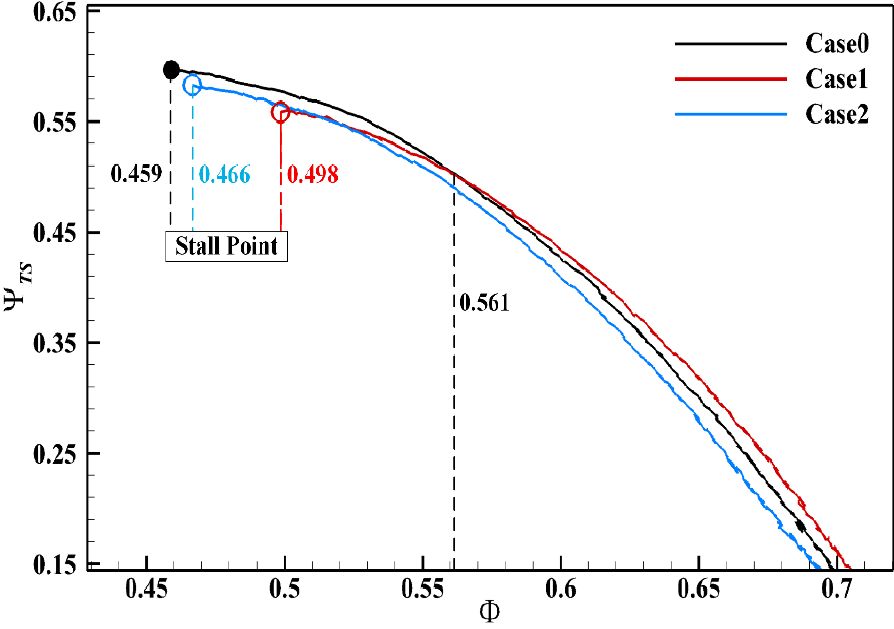
Figure 6. Total-static pressure rise characteristics for three stagger angle settings.